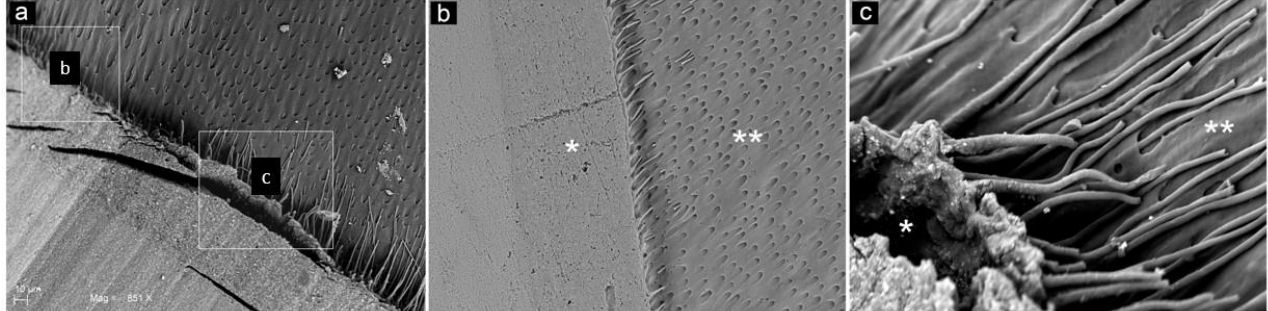
Figure 10. Representative SEM observations of the tooth-restoration interface for both WAPA and control groups: ( a ) SEM image of both types of preparation are visible: the WAPA is identified by square c , while control is identified by square b . Mag. 851×; ( b ) Higher magnification of control group (3000×). At the interface, between dentin (**) and the restoration material (*) the resin tags appear to be shorter and less developed if compared with those of ( c ); ( c ) Higher magnification of the WAPA group (4000×). At the interface, between dentin (**) and restoration material (*), the resin tags appeared to be more extended inside the dentin tubules.